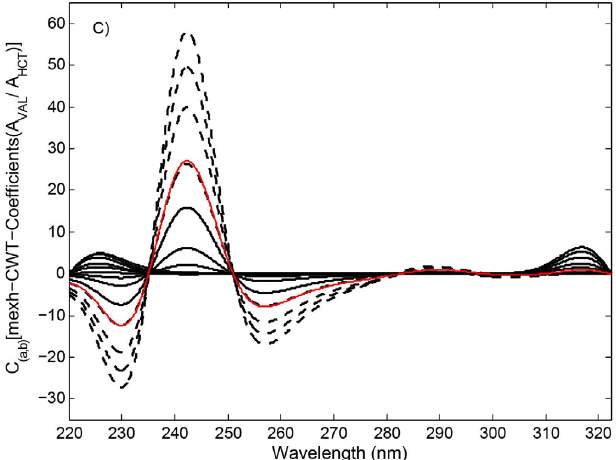
FIGURE 3C - RS-mexh-CWT spectra of VAL (----) : 1.0, 3.0, 9.0, 15.0, 21.0, 27.0, 33.0 µ g/mL and HCT (  ) : 1.0, 6.0, 11.0, 16.0, 21.0, 26.0 µ g/mL and tablet sample (  ) containing 2.50 µ g/mL of VAL and 16.0 µ g/mL of